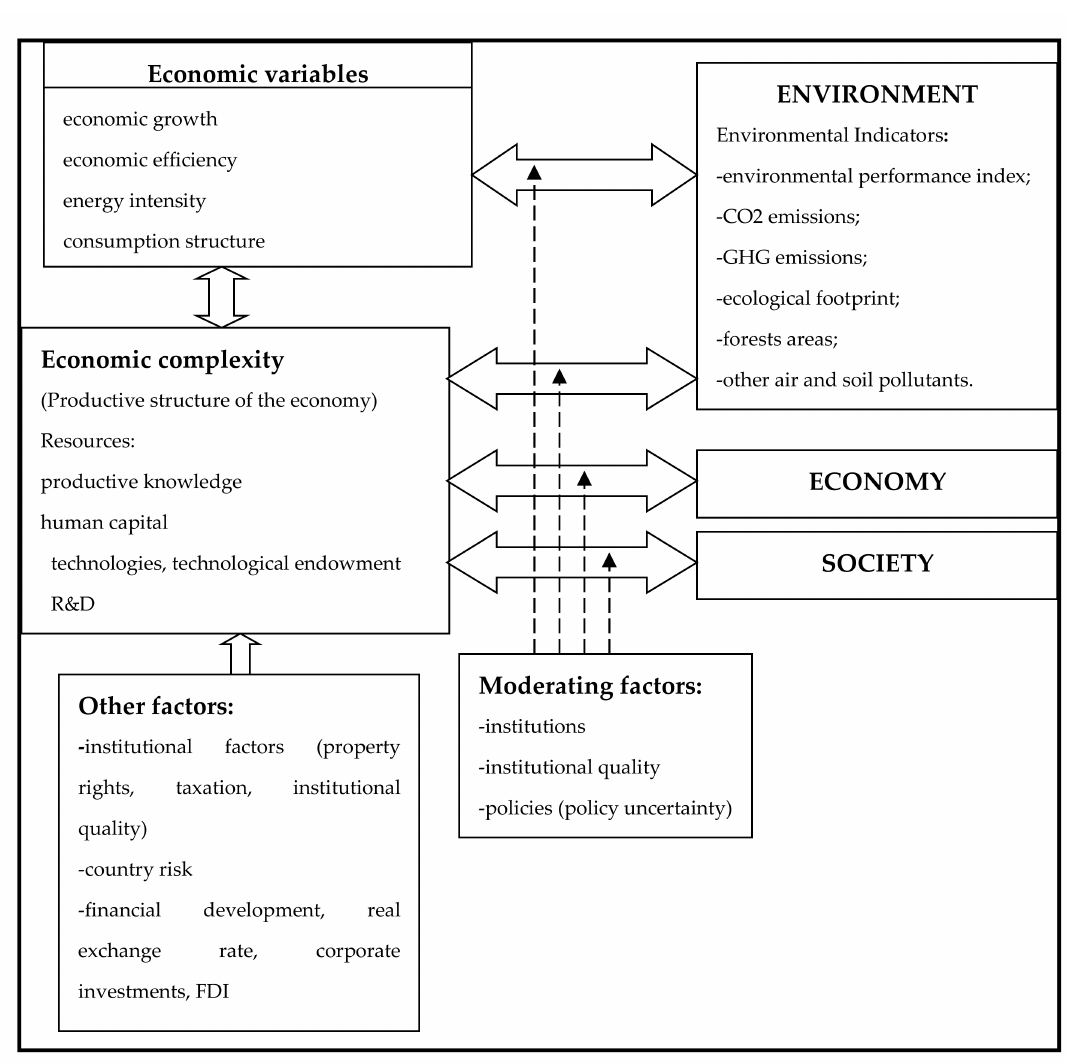
Figure 1. Linkages between economic complexity and environment, economy, and society, including moderating